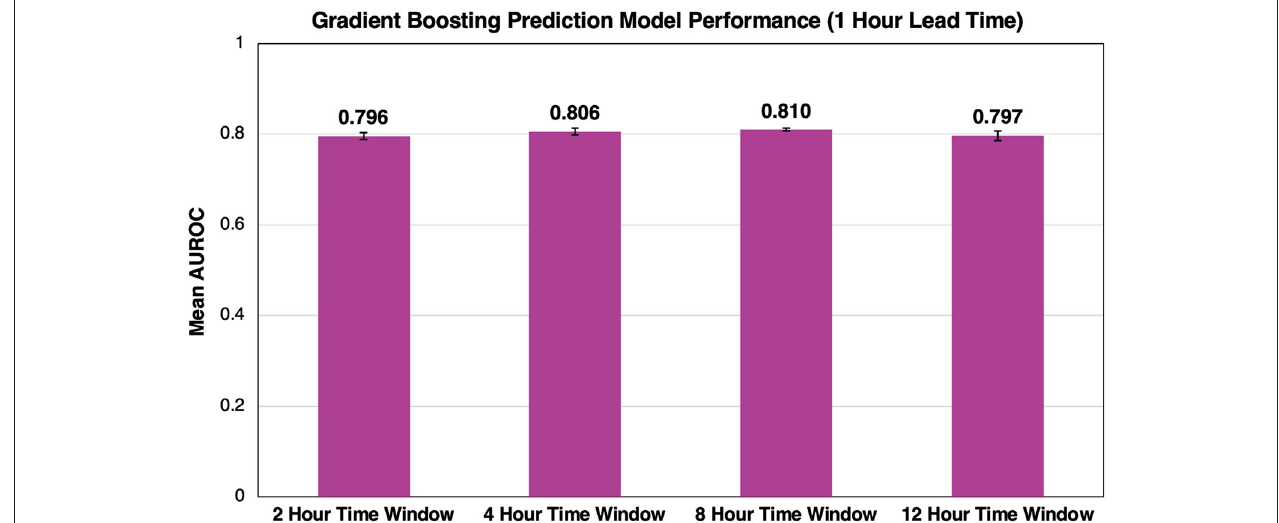
FIGURE 4 | Effect of time window size on AUROC performance. As we increase the time window size, we see minimal impact on the overall success of the model. Error bars represent 95% confidence intervals between our five cross-validation folds.